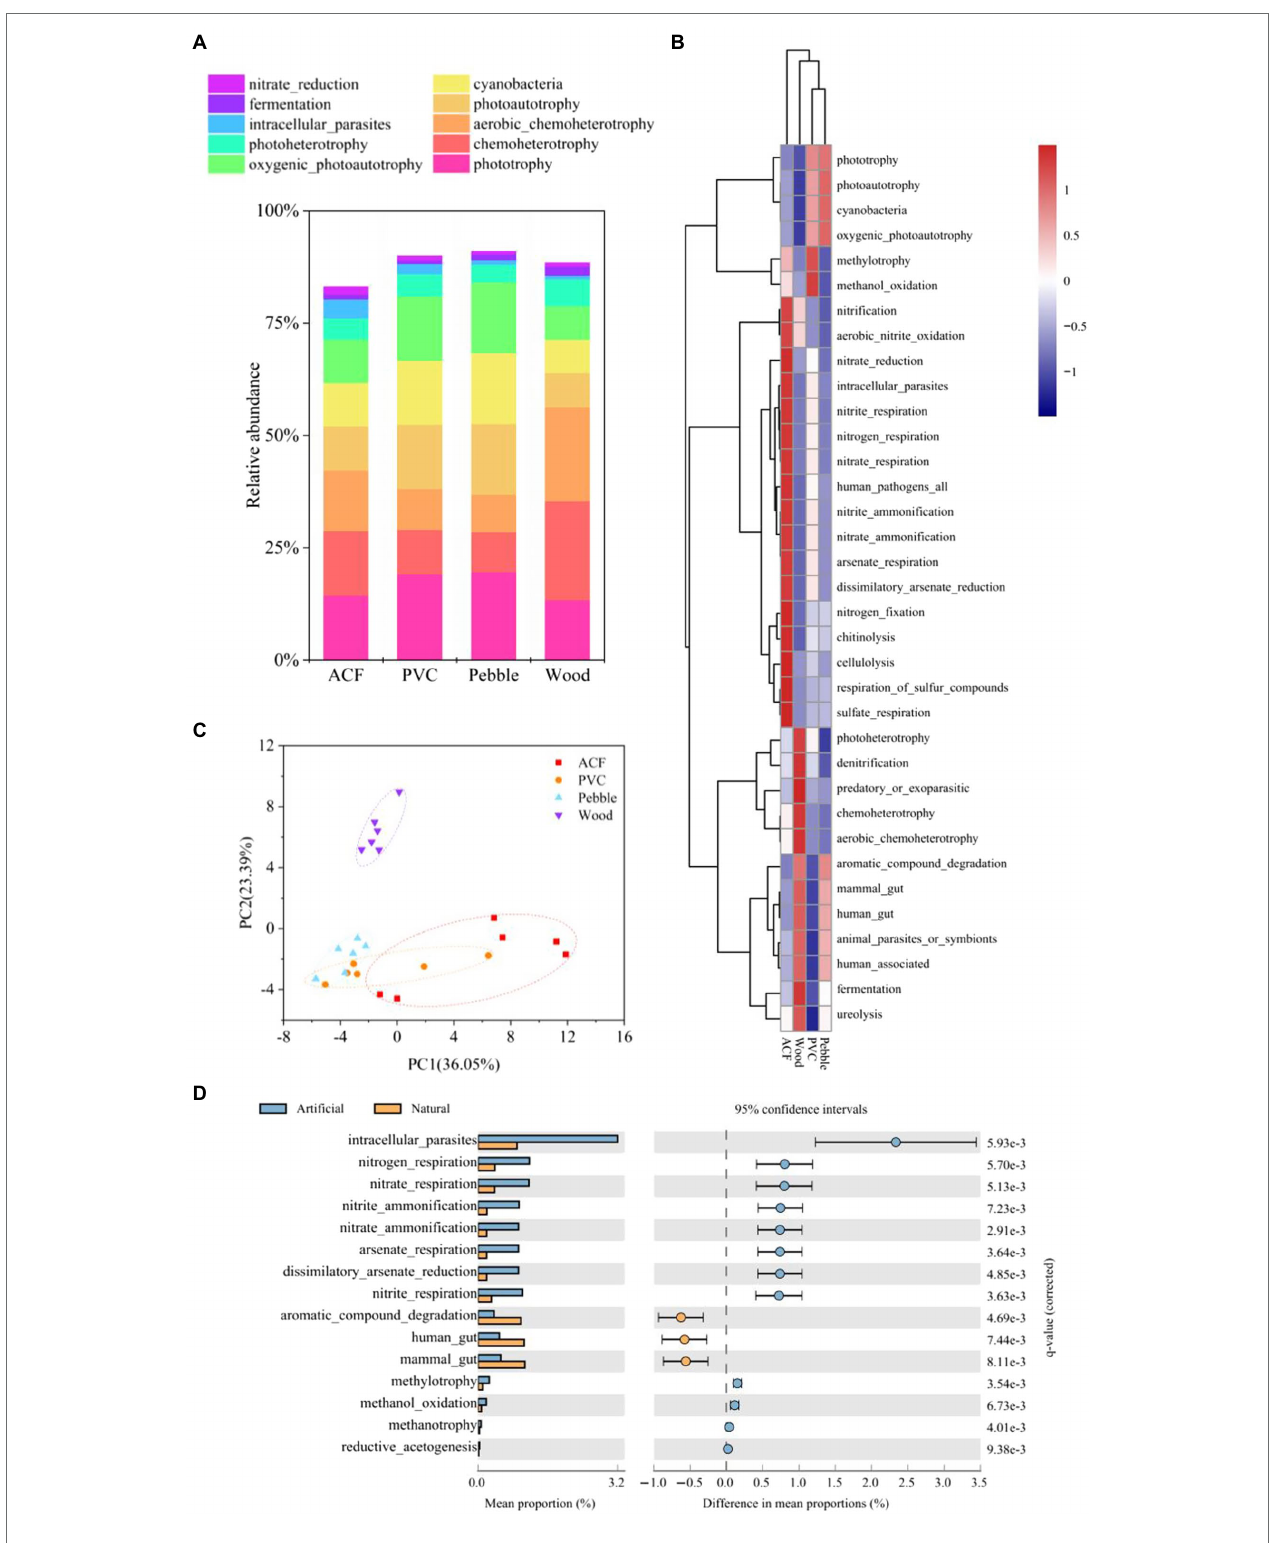
FIGURE 5 | (A) Relative abundance of the top 10 most abundant metabolic function pathways in bacterial biofilms from artificial (ACF and PVC) and natural (pebble and wood) substrates. Statistical comparison between the substrate types was performed using one-way ANOVA followed by Tukey’s post-hoc tests, and